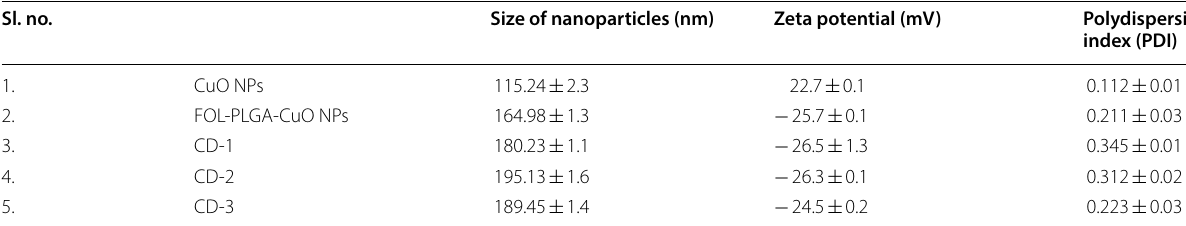
Note the shift in Zeta potential from